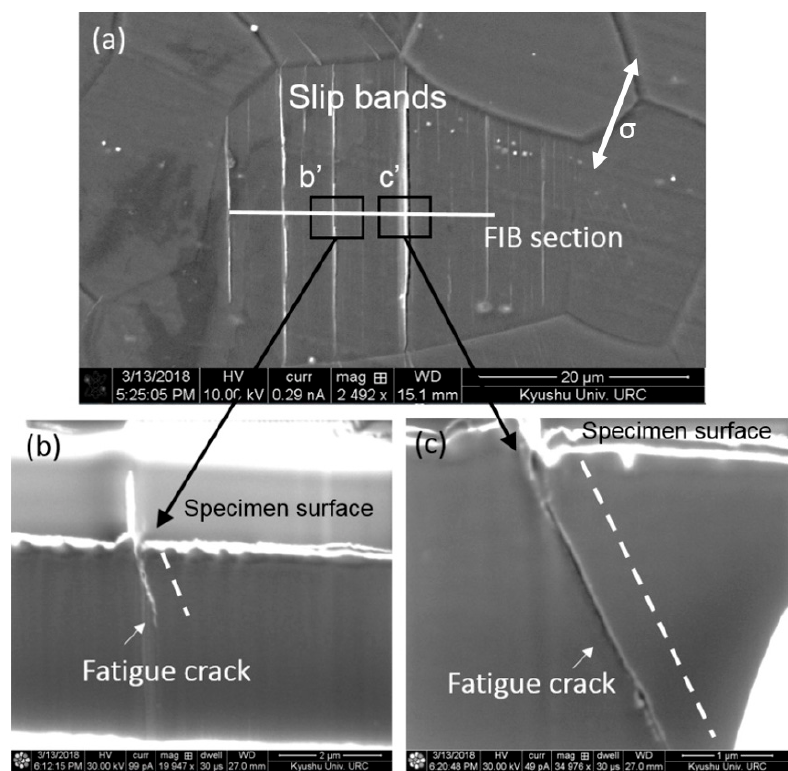
Figure 6. Micrograph of cross-sectioned slip bands by focus ion beam at 130 MPa. ( a ) Slip-induced fatigue cracking at specimen surface; ( b ) observation on the cross section of the slip band as plotted in ( a ); ( c ) straight crack path beneath the specimen surface.